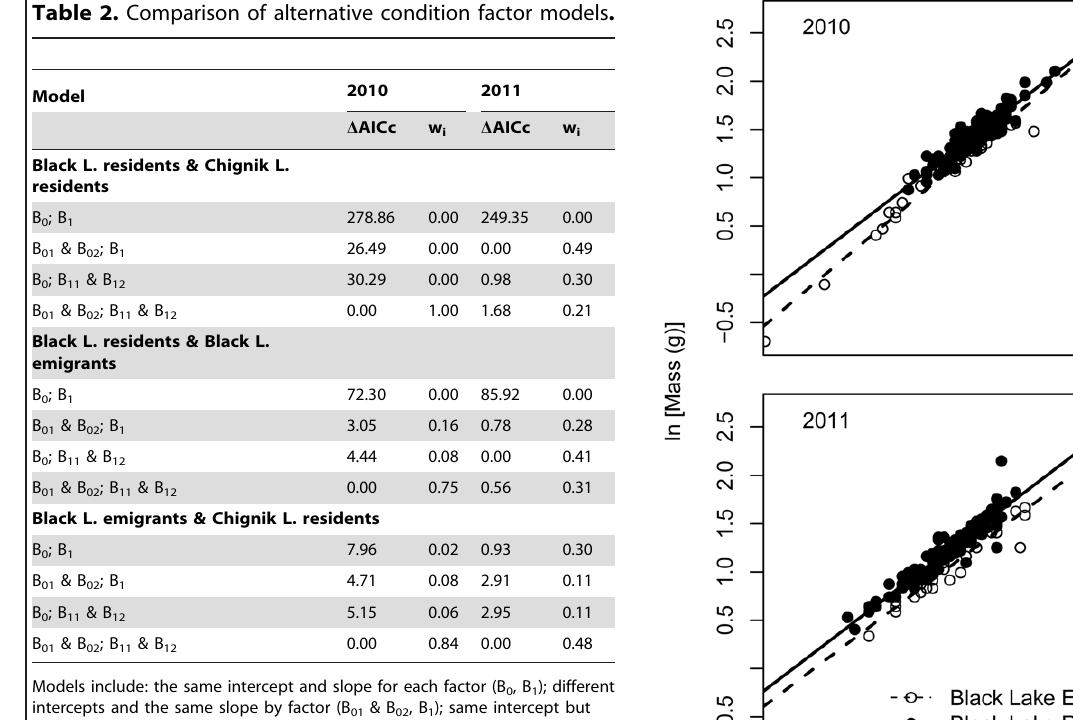
Table 2. Comparison of alternative condition factor models .